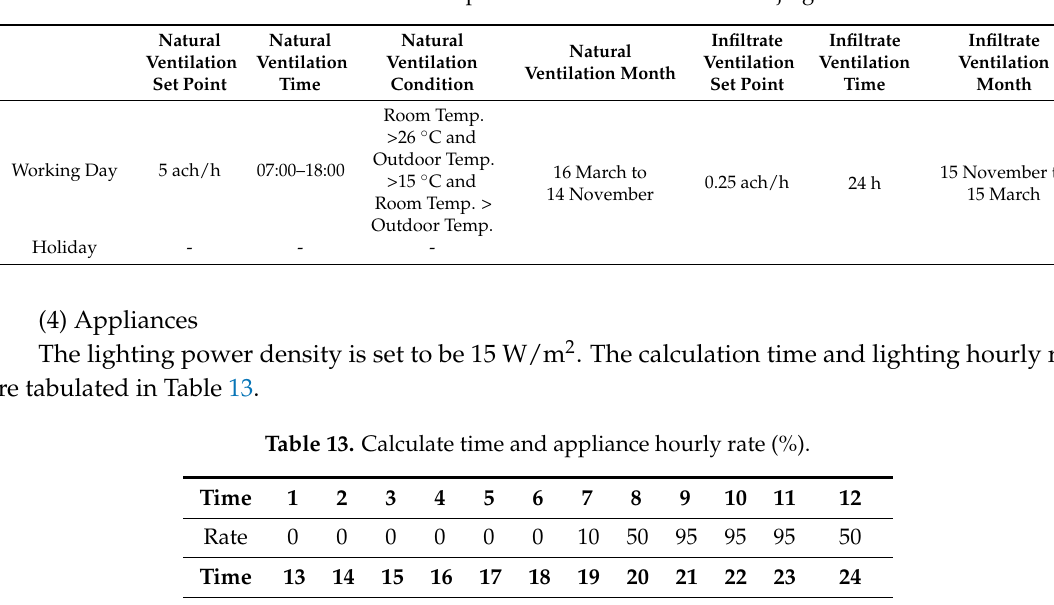
Table 12. Simulation parameters of ventilation in Beijing.